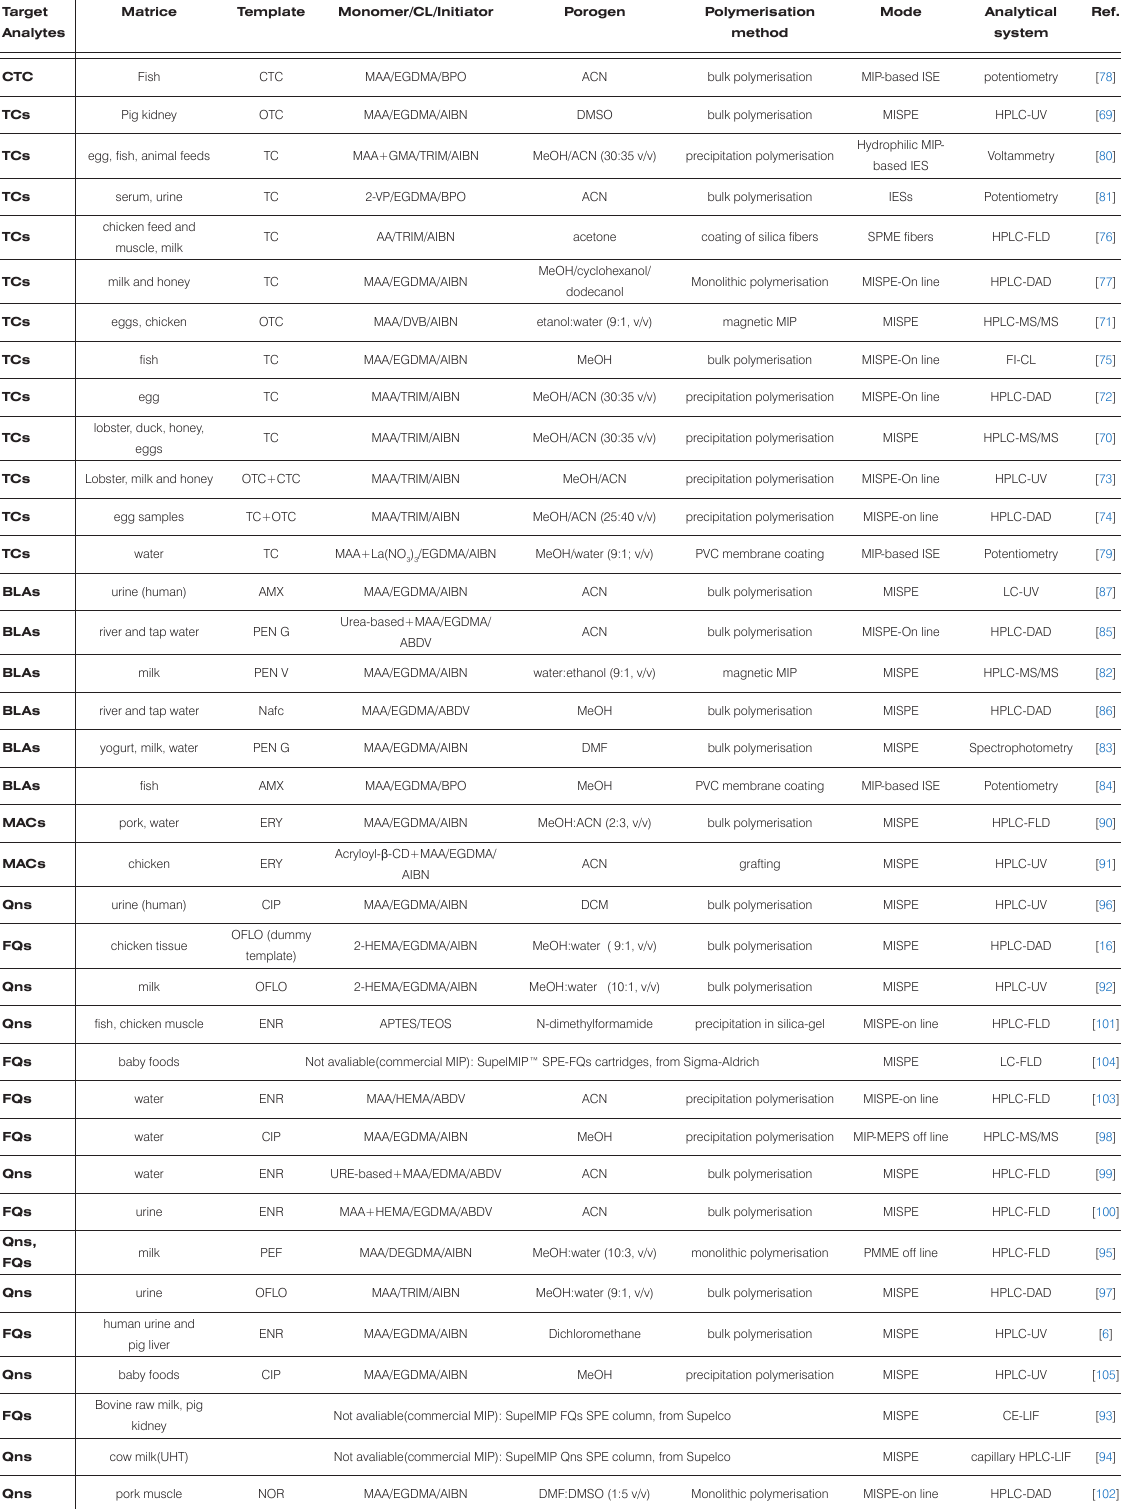
Table 2. Application of molecularly imprinted technology to the analysis of group B1 substances (Council Directive 96/23/EC) in